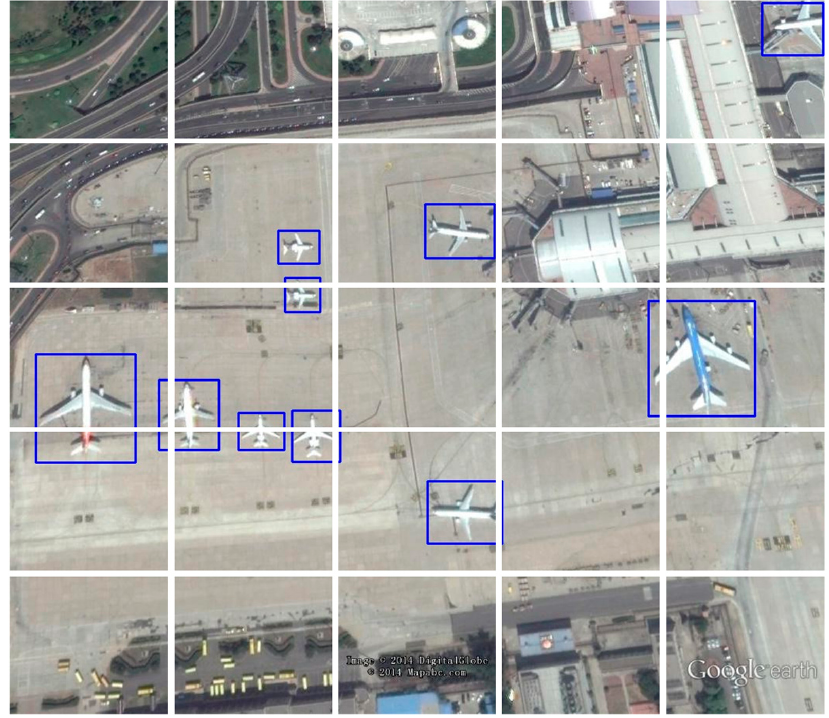
Figure 3. Vanilla patch embedding example. Patch splitting is represented by the white lines, while the ground-truth boxes are represented by the blue lines. Some targets’ semantics are compromised.